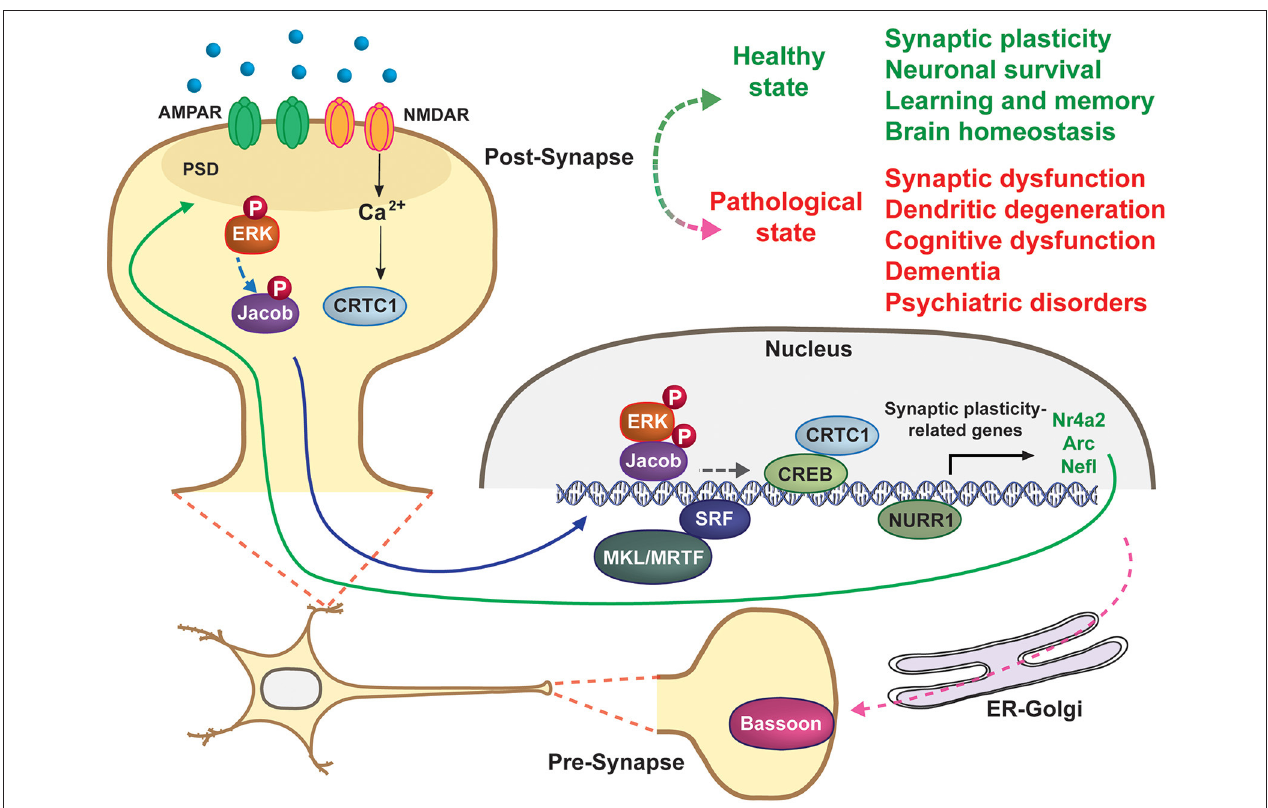
FIGURE 1 | Synapse-to-nucleus signaling regulates neuronal excitability and synapse plasticity. Several synaptic and dendritic factors (CRTC1, ERK, Jacob, MKL/MRTF, NURR1,…) are activated by synaptic activity at distal neuronal dendrites, including synapses, and then translocate to the nucleus to regulate gene transcription. Bassoon is an ER-Golgi pre-synaptic protein essential for vesicle release and neurotransmission. Blue line indicates signals traveling from dendritic spines or dendrites to the nucleus to regulate gene expression, whereas the solid green line shows how gene products act at synapses to regulate synaptic plasticity and neuronal excitability. Some brain physiological and pathological processes directly or indirectly regulated by synapse-to-nucleus signaling are indicated on the top